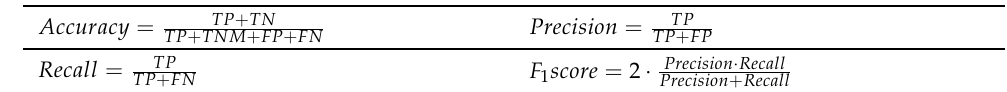
Table 1. Performance metrics.